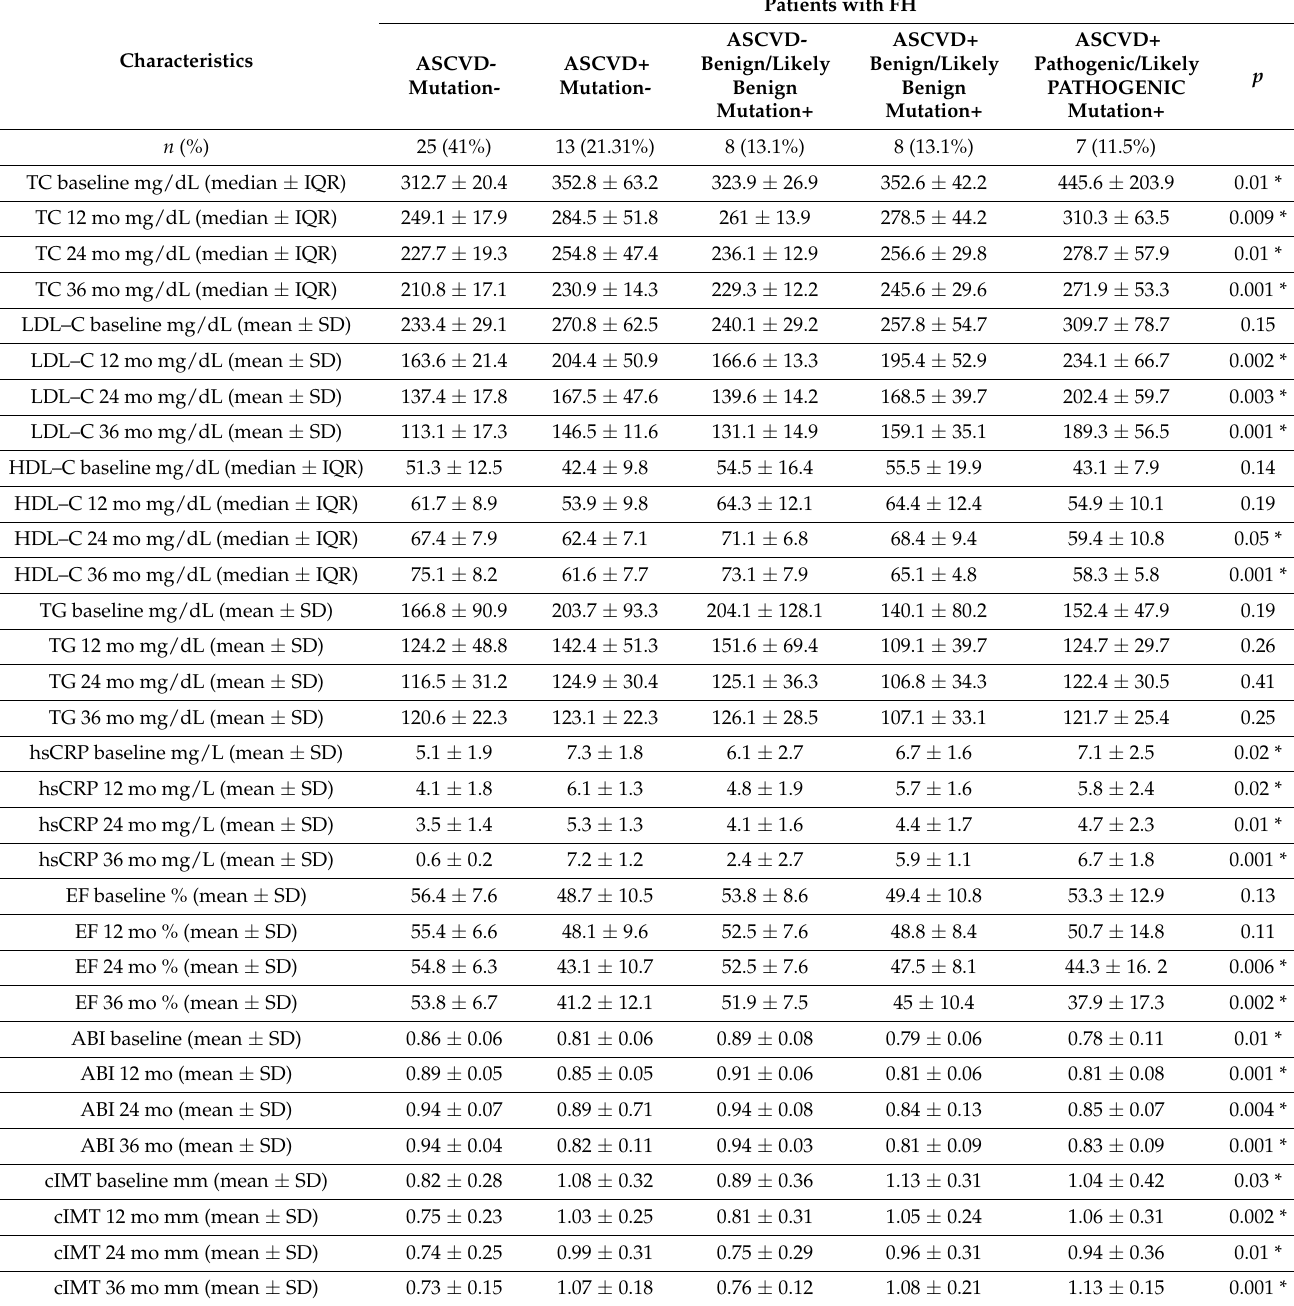
Table 3. The characteristics of FH patients according to cardiovascular